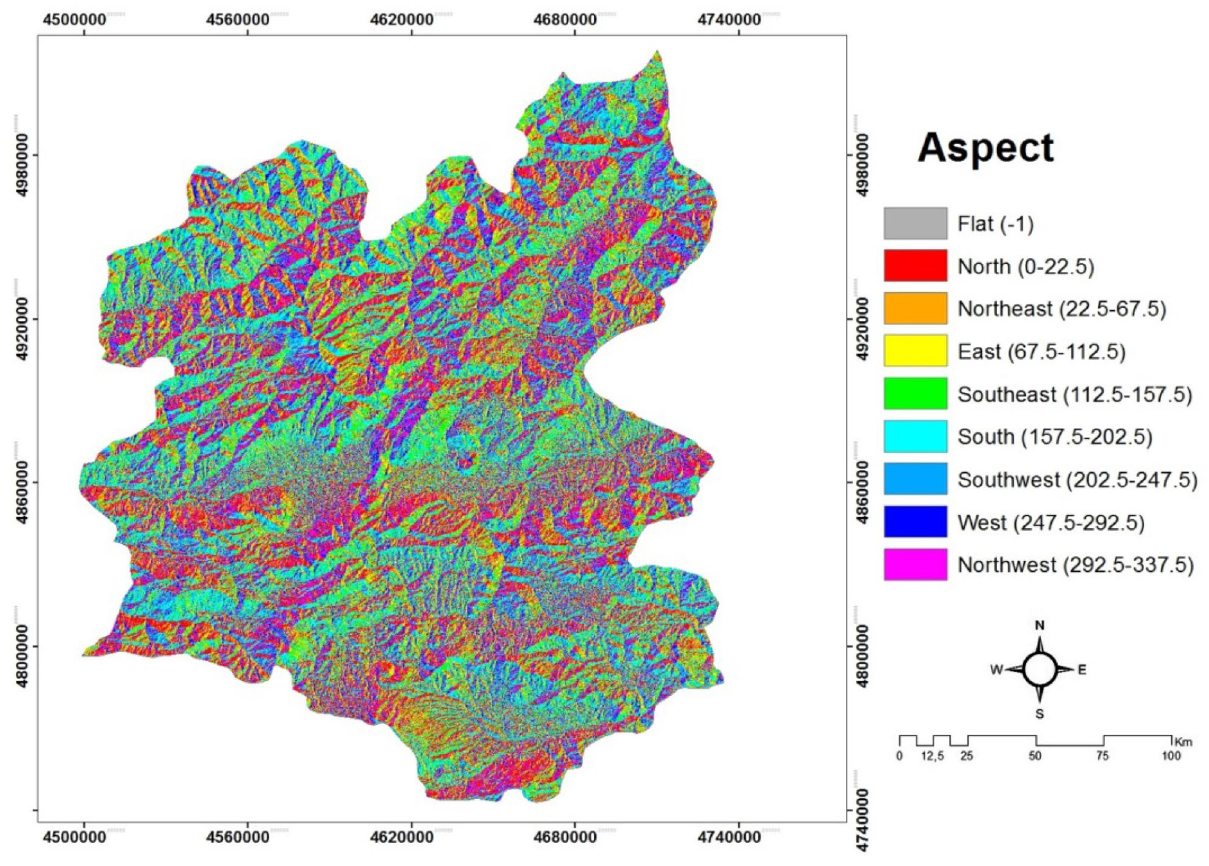
Figure 4. The aspect map of